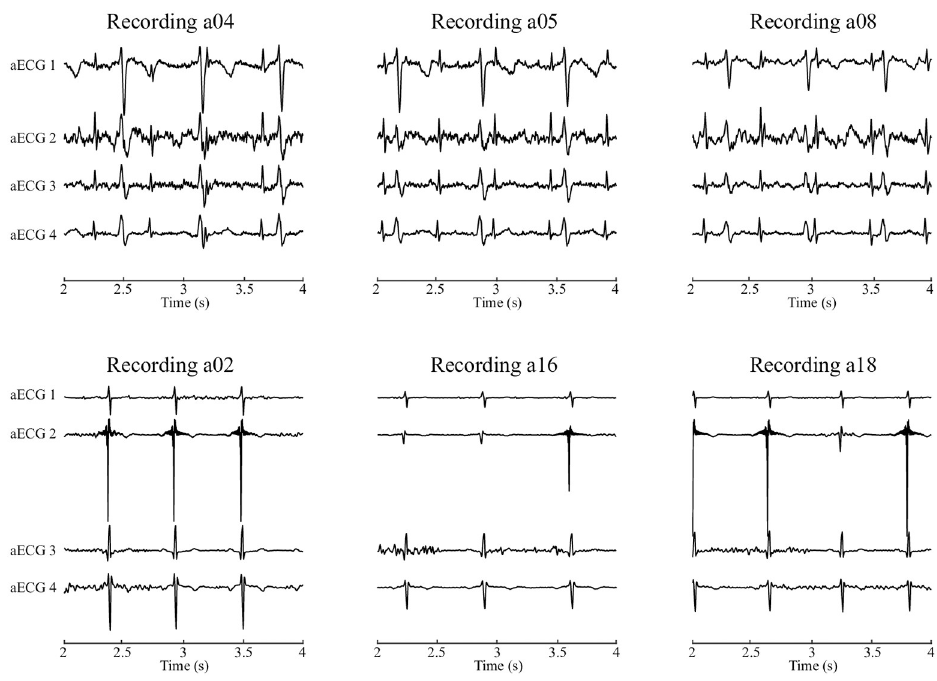
Fig 9. Examples of aECG signals from the challenge 2013 database. Three of high quality (a04, a05, a08) and three of low quality (a02, a16, a18).